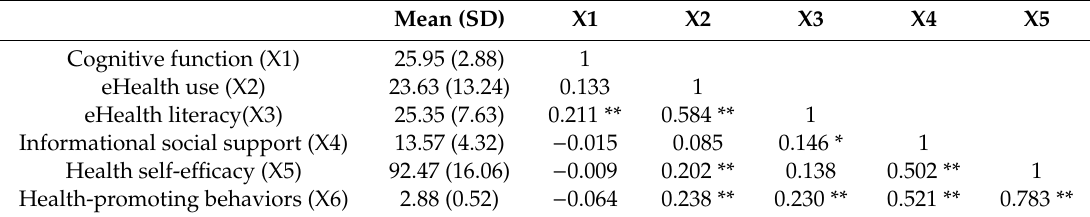
Table 4. Correlations between main variables (N =